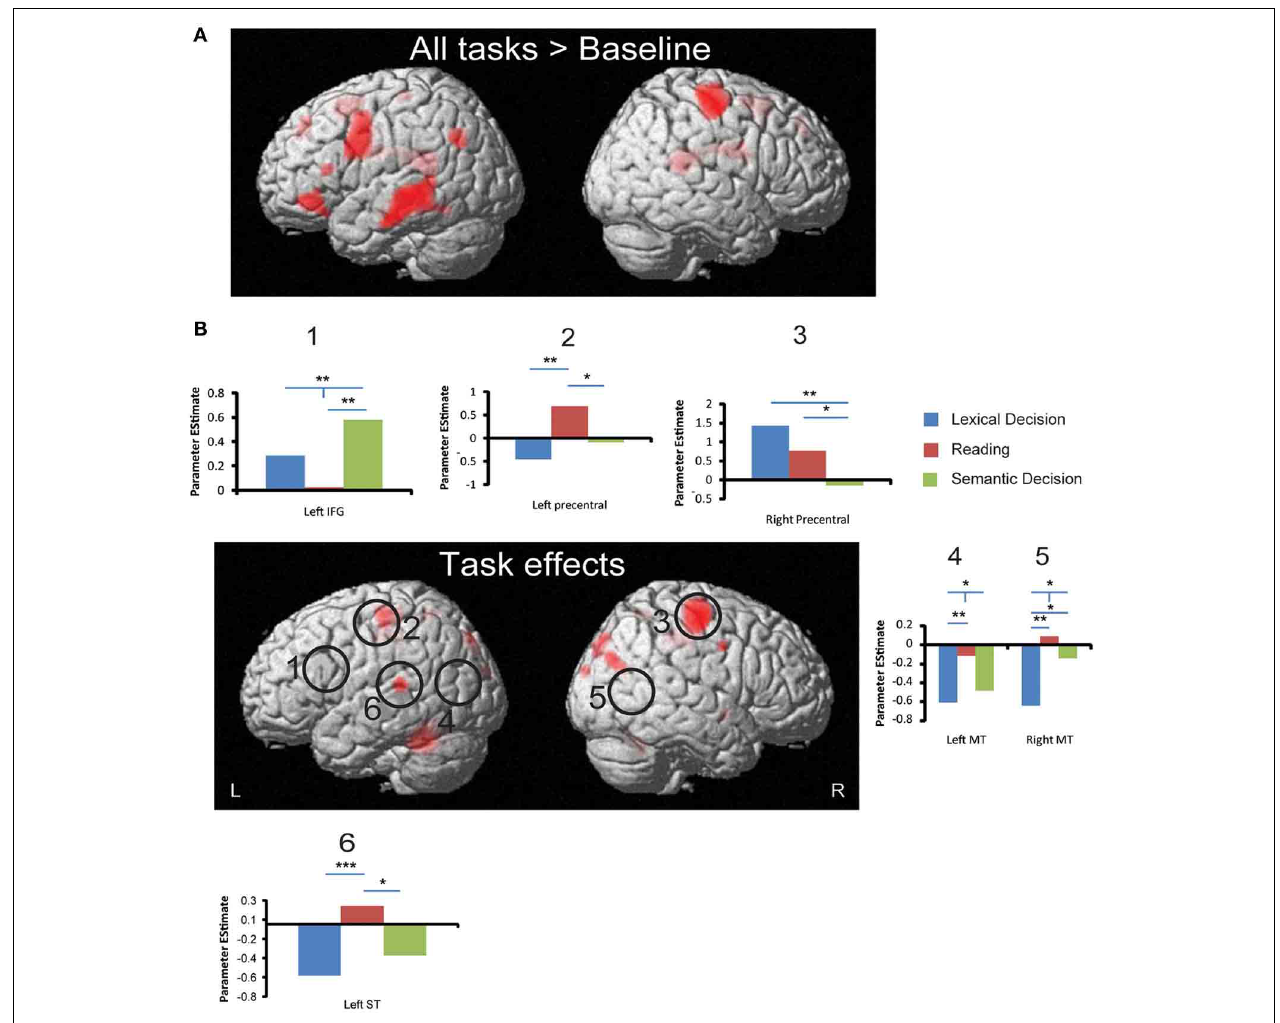
correction. Bar graphs show significant ROI analysis results in more detail (significance levels indicated as in Figure 3 ). All whole-brain results are displayed at a significance threshold of p < 0 . 001 uncorrected with minimum extent of 10 voxels (see Table 3 for details). ∗ p < 0.05, ∗∗ p < 0.01, ∗∗∗ p <